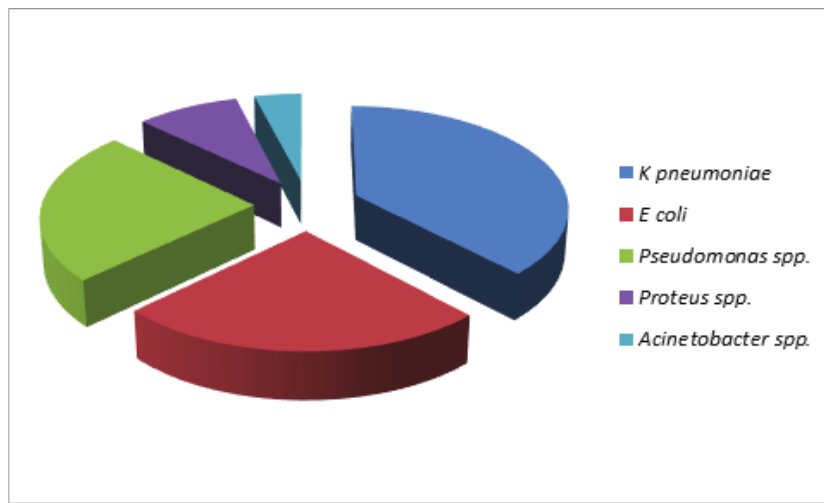
Figure 1: Gram-positive bacteria cultured from hospitalized infected patients over an eight-months period with S. aureus being the most common in all four hospitals.